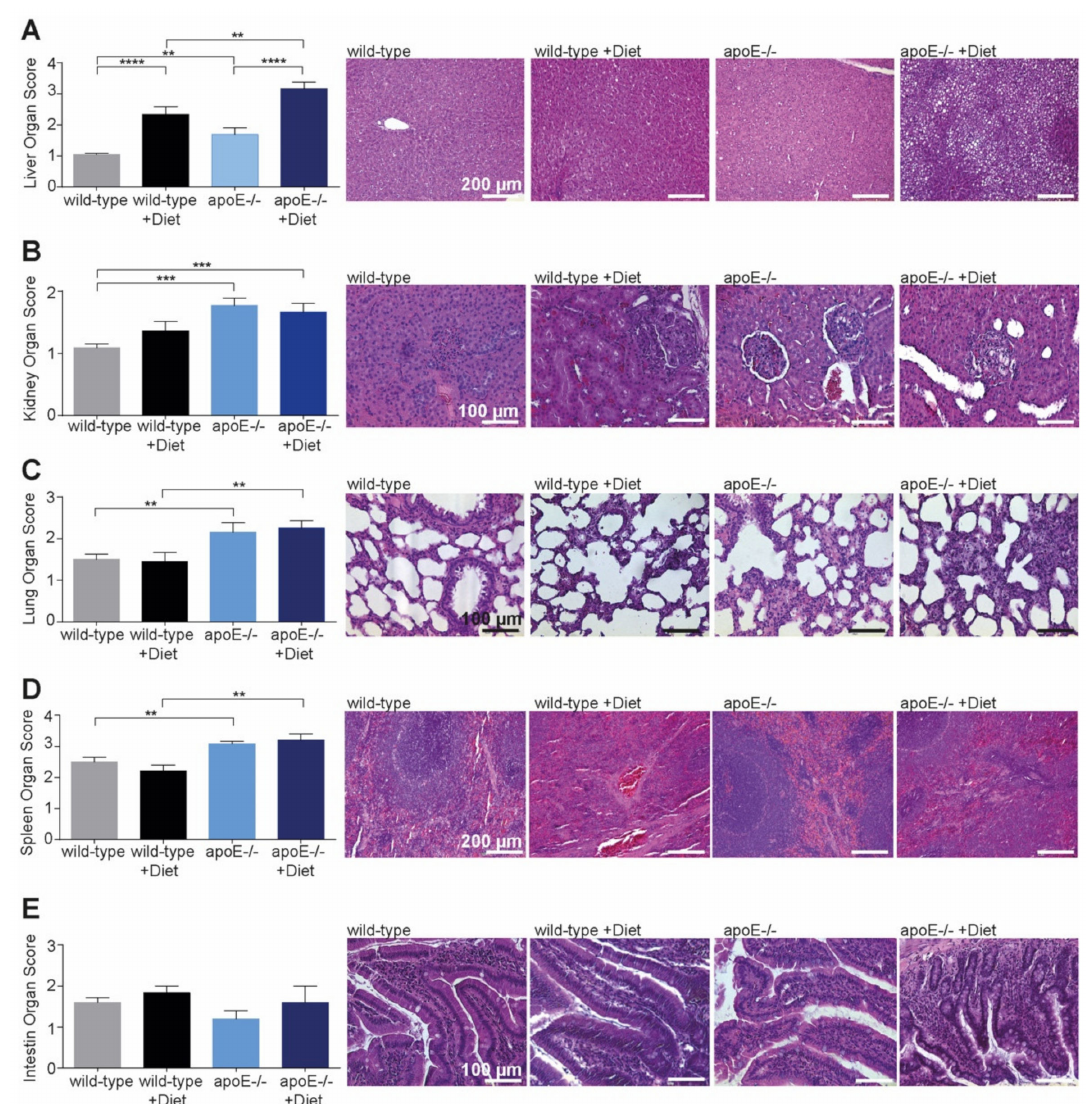
Figure 2. Changes in organ morphology of apoE − / − rats after feeding high-fat diet ( A – E ). Twelve weeks (age 20 weeks) after feeding normal or high-fat diet, apoE − / − rats showed pathological changes in almost all organs compared with wild-type rats. While pathological changes in kidney, lung, and spleen were not related to diet, the liver was dramatically affected by high-fat diet, especially in apoE − / − . ** p < 0.0, *** p < 0.001, **** p < 0.0001, n = 5–15, scale bar is indicated in the first image of each